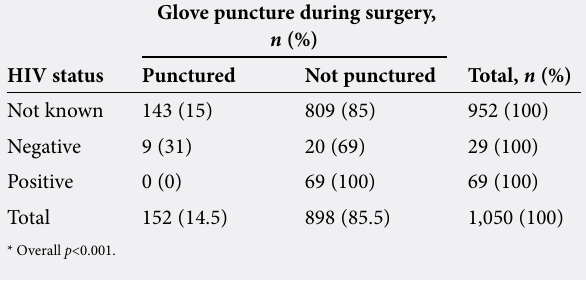
Table 3. Analysis of glove puncture and HIV status*